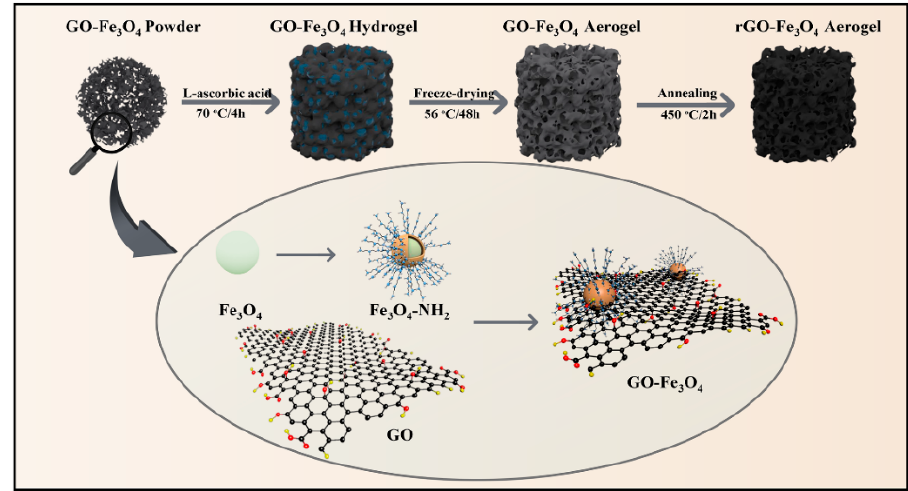
Figure 7. Covalently bonded Fe 3 O 4 nanoparticles onto graphene. Reprinted with permission from [41]. Copyright@ Springer–Nature.